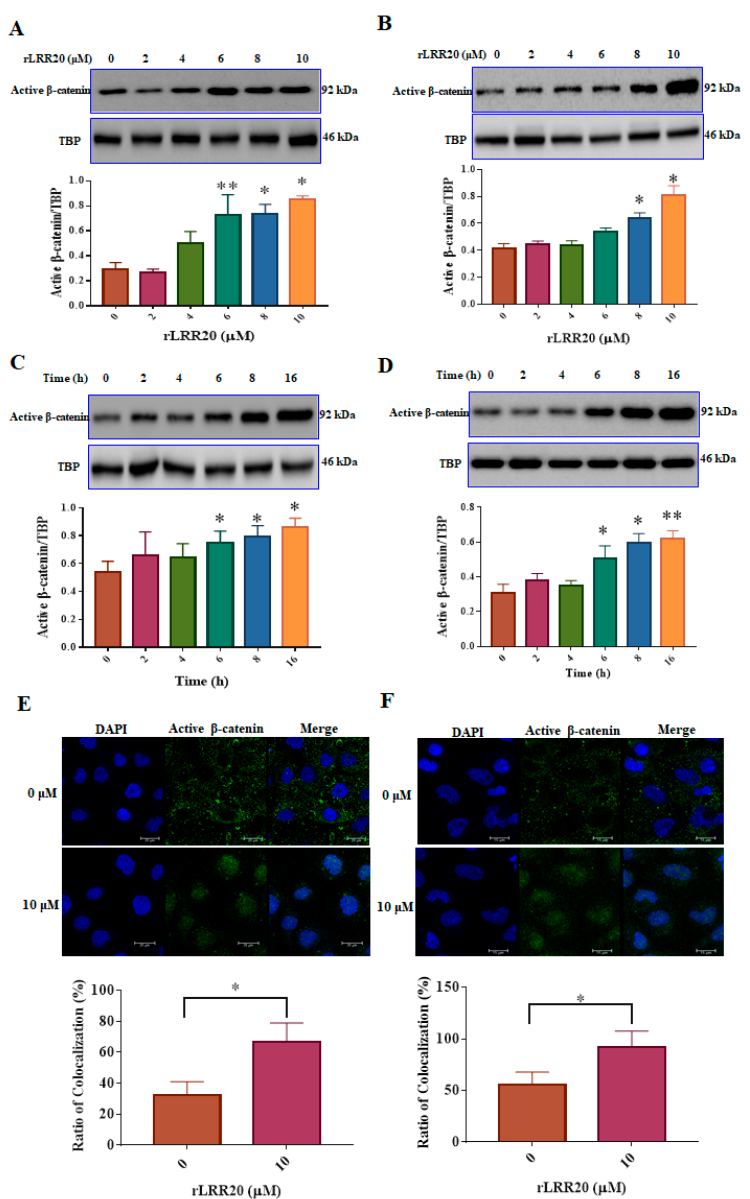
that rLRR20 dose-dependently and time-dependently upregulated the expression of active MMP7 (Figure S3).